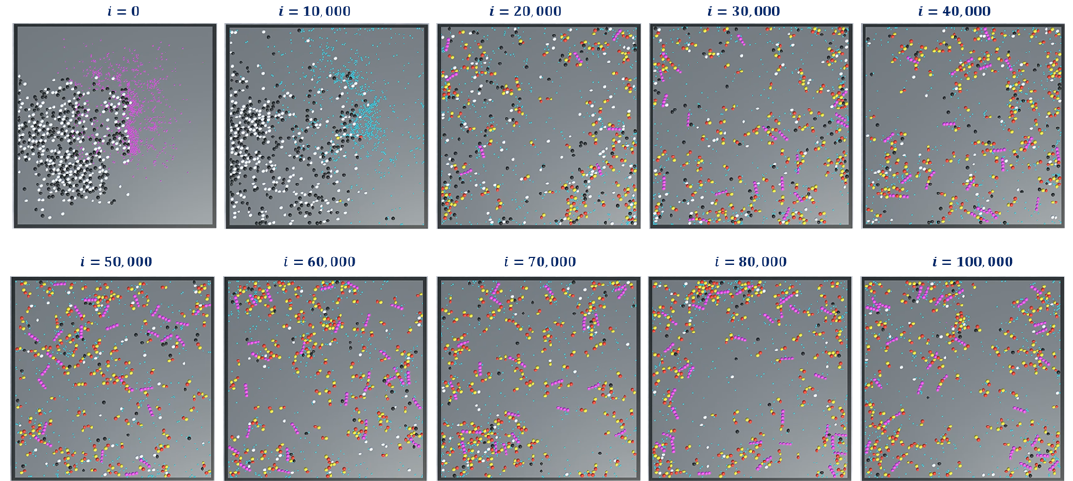
Figure 15. Snapshots of simulation-4 showing formation of protofilaments from tubulins, with extended rules. The simulation was run for 300 of each of α and β tubulins, 600 GTPs, P GTP = 1 and 100,000